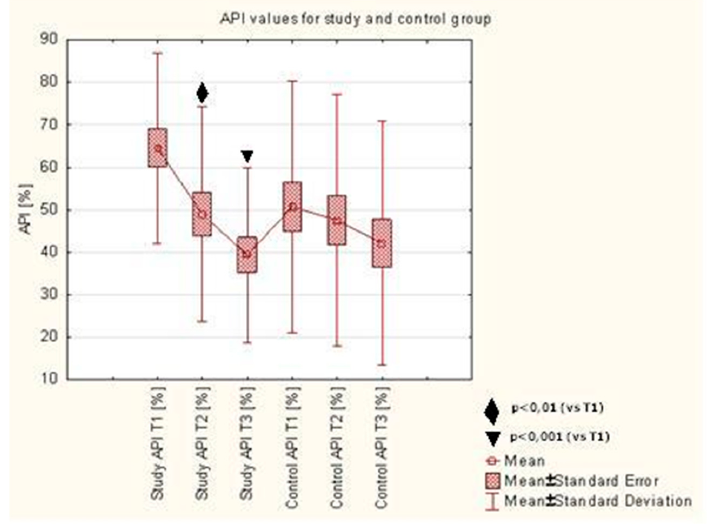
Figure 1. Approximal plaque index (API) values in study and control groups.